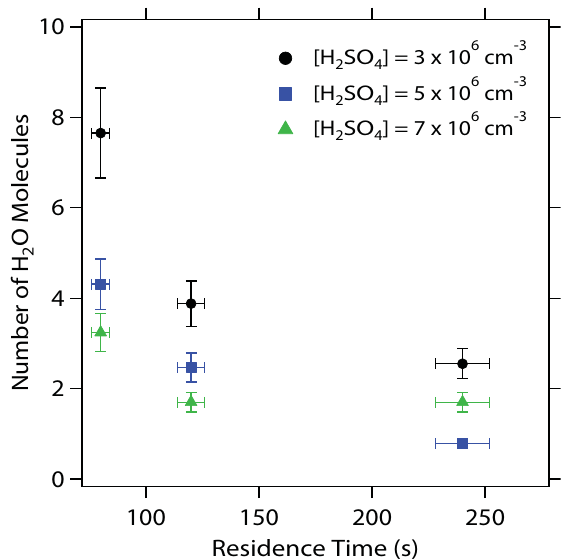
Fig. 4. The n H values (derived from Log J vs. Log RH) as a 2 O function of residence time and [H 2 SO 4 ]. The horizontal and verti- cal bars indicate one standard variation in residence time and n H